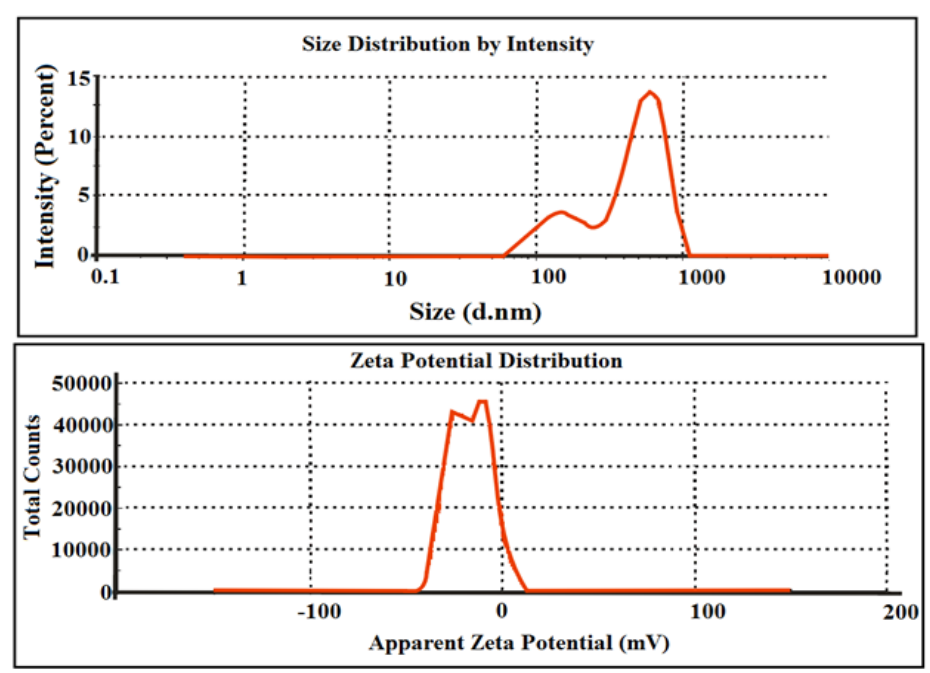
Figure 5. TGA plot of the starch-based AC.